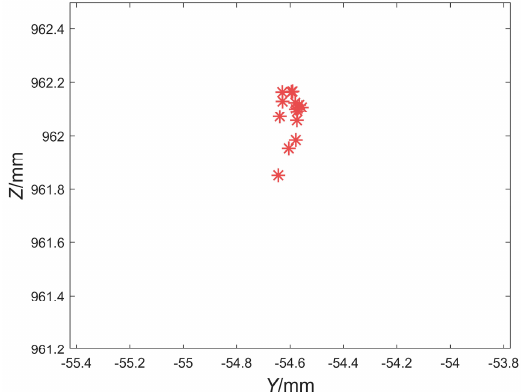
Table 4. The standard deviation in the Y w and Z w directions. Figure 12. Photocentric coordinate distribution map. Figure 12. Photocentric coordinate distribution map.